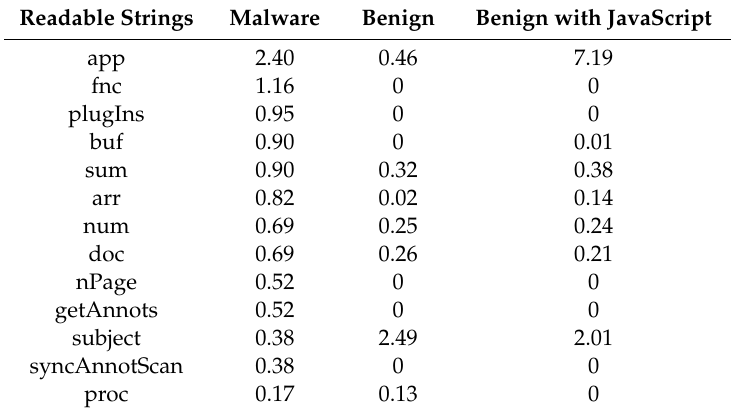
Table 5. The average count of top readable words in